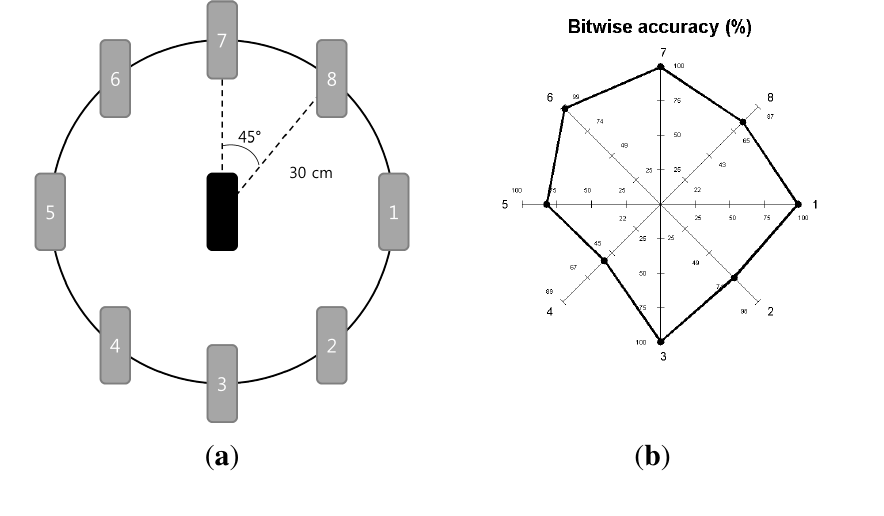
Figure 13. The black rounded-edge rectangle in the middle is the transmitter, and tested locations of the received are shown as gray rounded-edge rectangles. Locations are labeled to make the reference easier. Bitwise accuracy at different communication directions from the transmitter. The locations of the receiver are shown in Figure 13a. ( a ) Overall setting; ( b ) bitwise